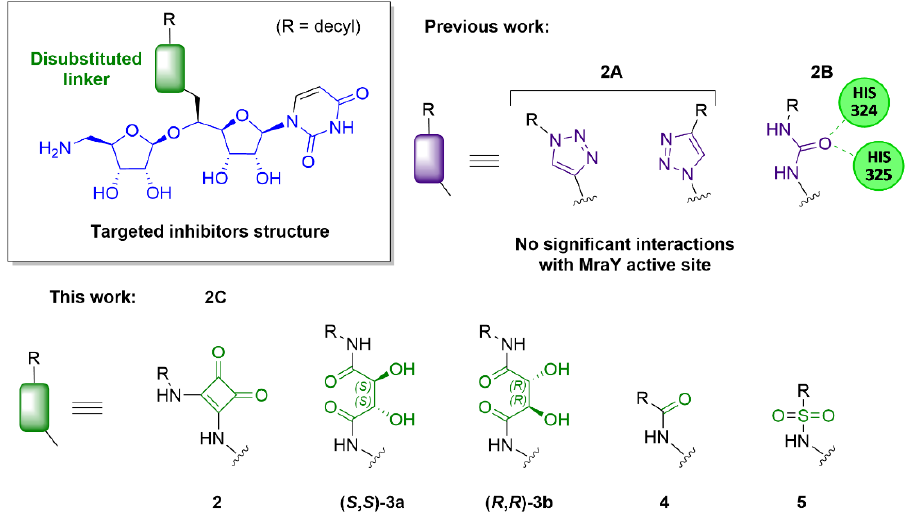
Figure 2. Structure of the synthesized and targeted aminoribosyl uridine-containing inhibitors with various linkers. Previous work: 2A and 2B . This work: 2C .